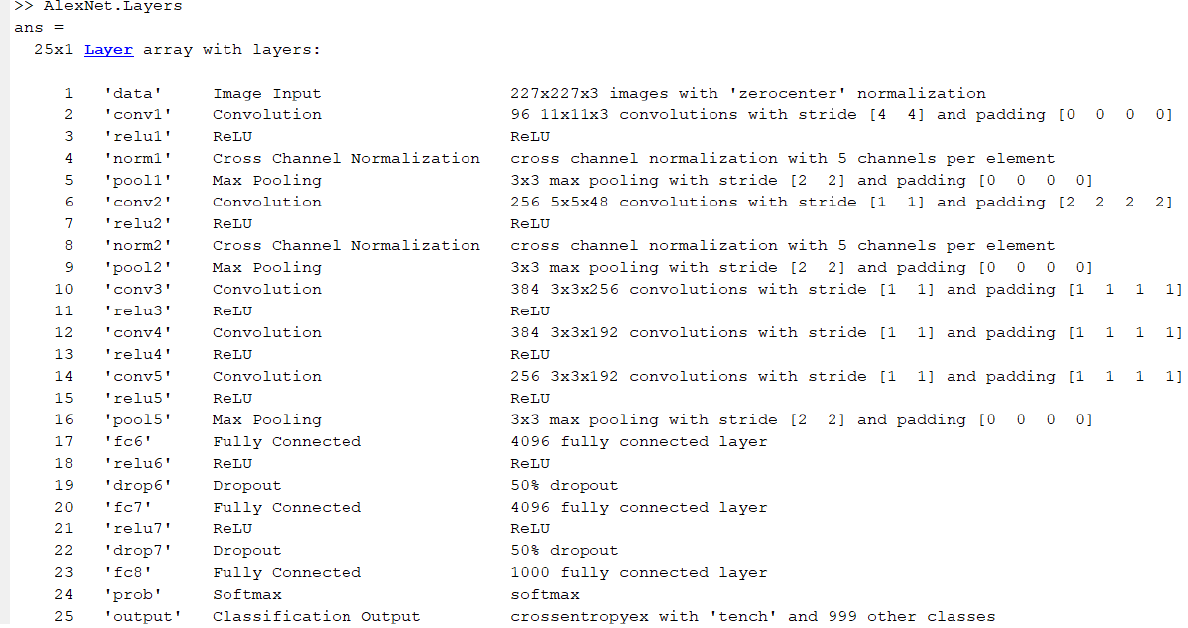
Fig. 1. The AlexNet CNN architecture in M ATLAB . ReLU layers are typical, pooling layers are atypical, and 2 DropOut layers are inserted to prevent overfitting.